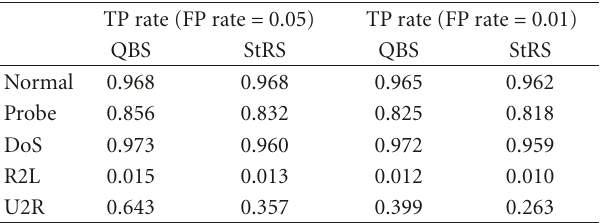
Table 6: Keeping FP rate constant to demonstrate QBS outperforms